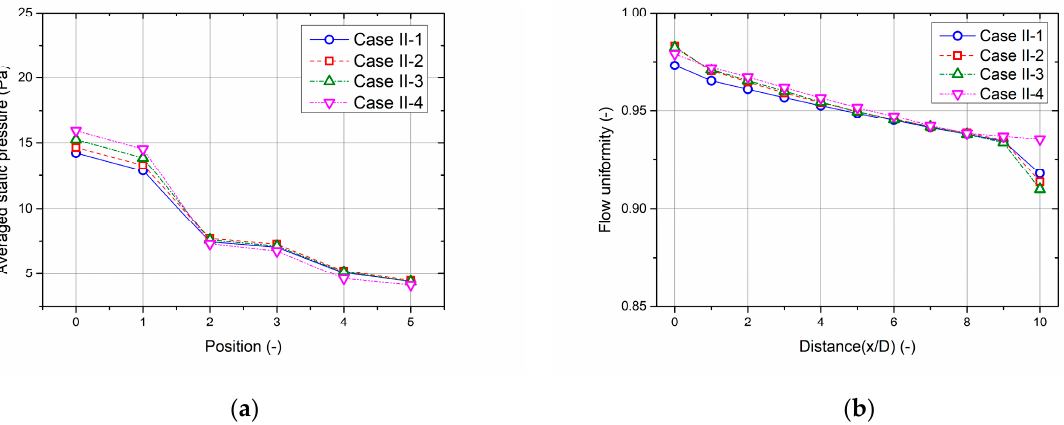
Figure 8. Simulation results: ( a ) the static pressure distribution; ( b ) flow uniformity distribution. With regard to the design of the inlet and outlet angle of the brake dynamometer enclosure, the residence time of brake dust in the brake dynamometer was 3.93, 1.99, 3.27, 2.60 s for the Case II-1 ~ 4. The residence time of brake dust particles in the dynamometer was shortest with an inlet and outlet angle of α = 10°. However, the particles had more rotational motion trajectories near the fixed axis, indicating that the turbulence formed by the rotation of the brake disc was greatly affected. During the laboratory measurement of brake dust, the variable that controlled the intake turbulence should be the main factor. The turbulence of the brake disc affects the residence time of the brake dust, which is difficult to control. With the entrance angle of the brake dynamometer enclosure set to α = 15°, the residence time of the brake dust in the brake dynamometer was 3.20 s, which is